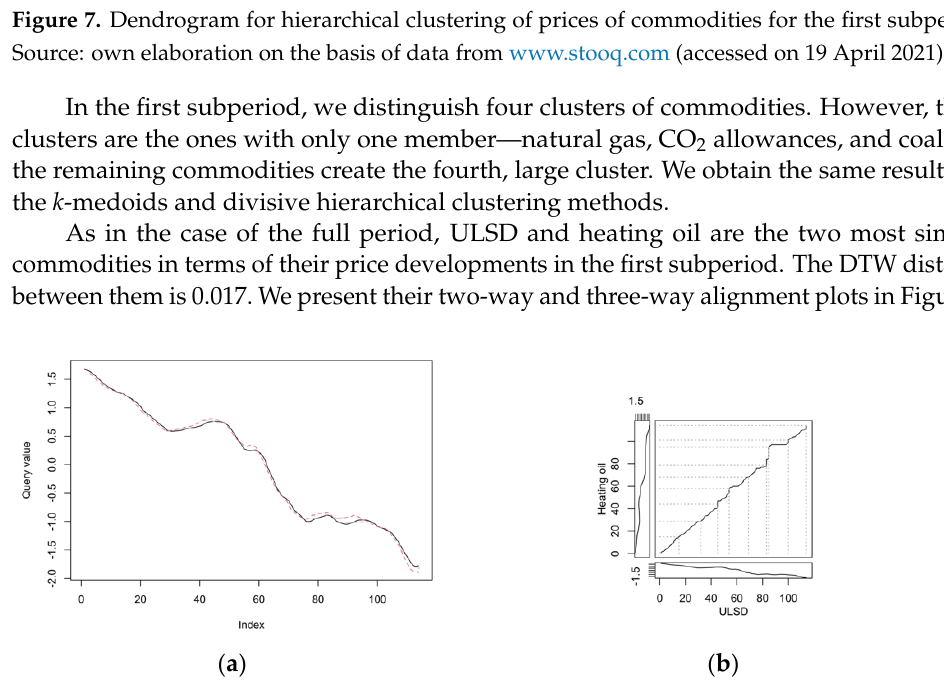
Figure 7. Dendrogram for hierarchical clustering of prices of commodities for the first subperiod. Source: own elaboration on the basis of data from www.stooq.com (accessed on 19 April 2021).